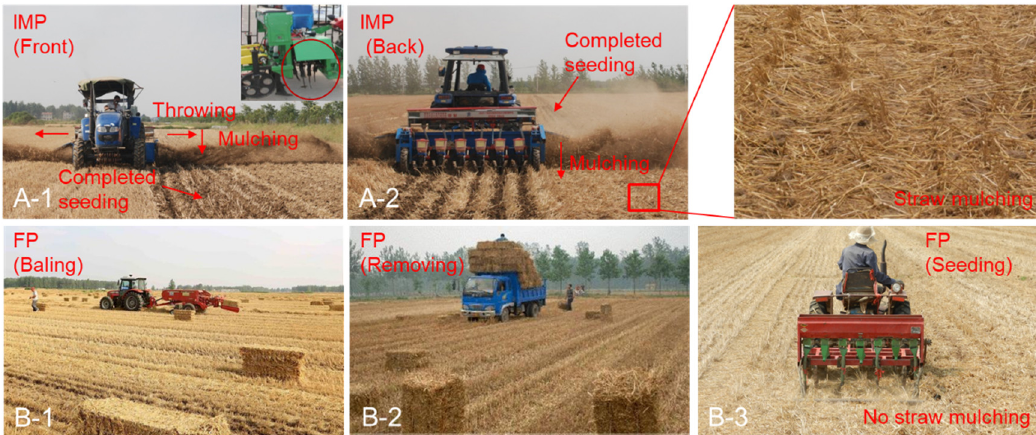
Figure 1. The operation of the two seeding management practices. IMP, integrated management practice; FP, farmers’ practice. Under IMP, the seeding and straw returning treatment are completed in one operation ( A ). Under FP, straw baling, straw removing, and seeding are completed in three times ( B ). Table 2. Description of soybean seeding management practices.